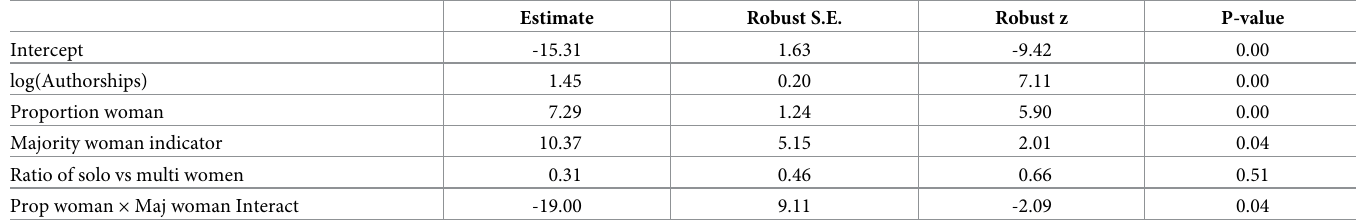
Table 2. Secondary analysis. Results of the logistic regression using significant behavioral homophily with a .05 cut-off under the Benjamini-Yekutieli FDR procedure as the dependent variable. The results when using the Benjamini-Hochberg FDR procedure and .005 cut-off are included in the